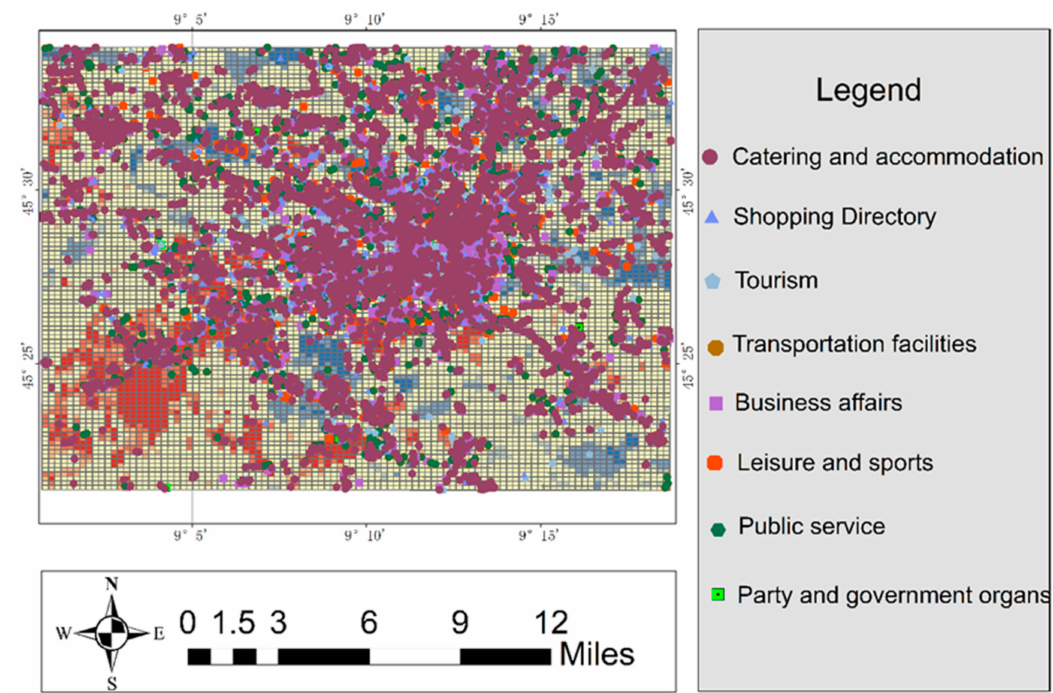
Figure 15. Map overlay of the detected hot/cold spots with the POI dataset. (2) Quantity distribution comparison of geographical features dataset contained by hot/cold spots detected.